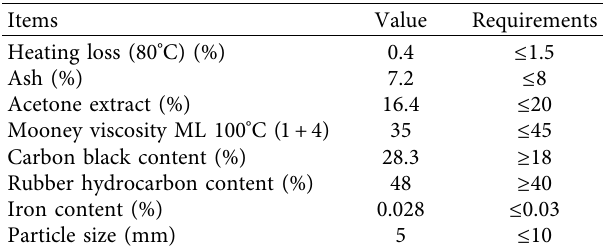
Table 3: The technical indicators of desulfurized rubber powder.